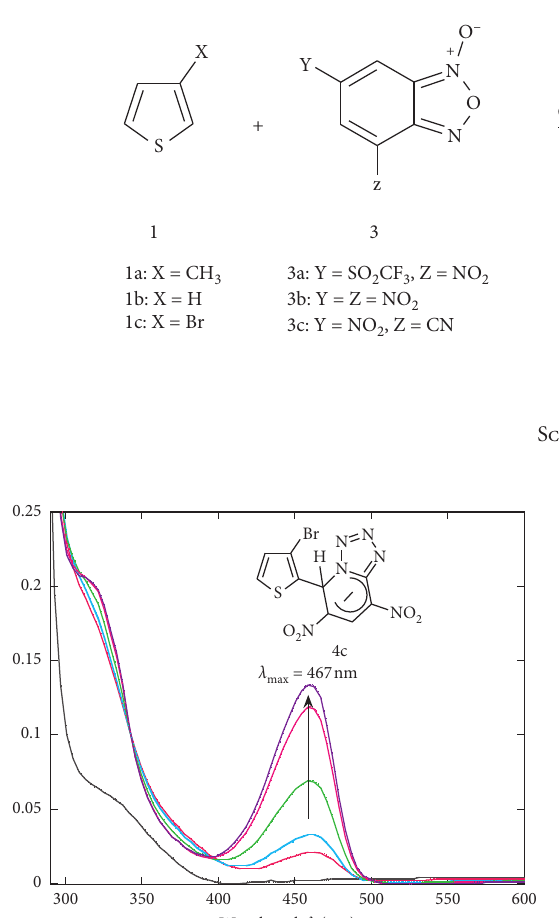
Table S4: physical data for the formation of σ -adducts 4A-C and 5A-I derived from the reaction of 3-X-substituted thiophenes 1a-c with the electrophiles 2a and 3a-c .